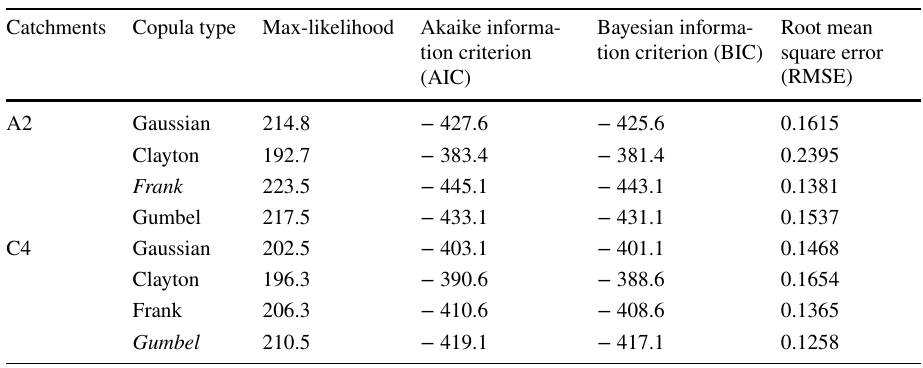
Fig. 4 Isolines of extreme paired data based on the Frank and Gumbel copulas. a Catch- ment A2; b Catchment C4. The yellow squares show the design values under different joint return periods between the extreme surge and rainfall using the most-likely